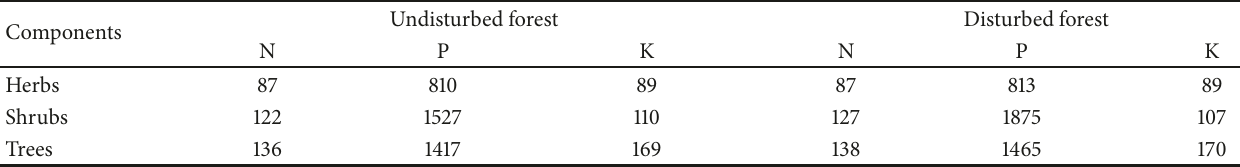
Table 9: Nutrient-use efficiency of different nutrients in different growth forms in undisturbed and disturbed stands of moist tropical forest in Sunsari district, eastern Nepal.